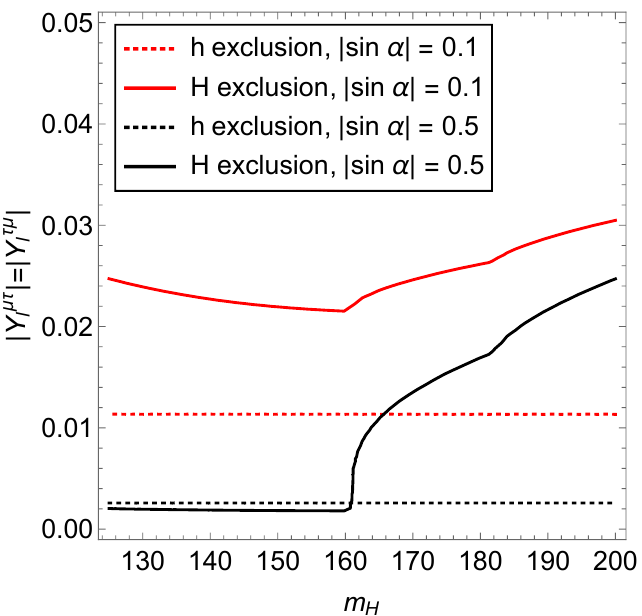
Figure 23. The estimated bounds from LFV decays of h and H in the case of nonzero Y (cid:28)(cid:28)